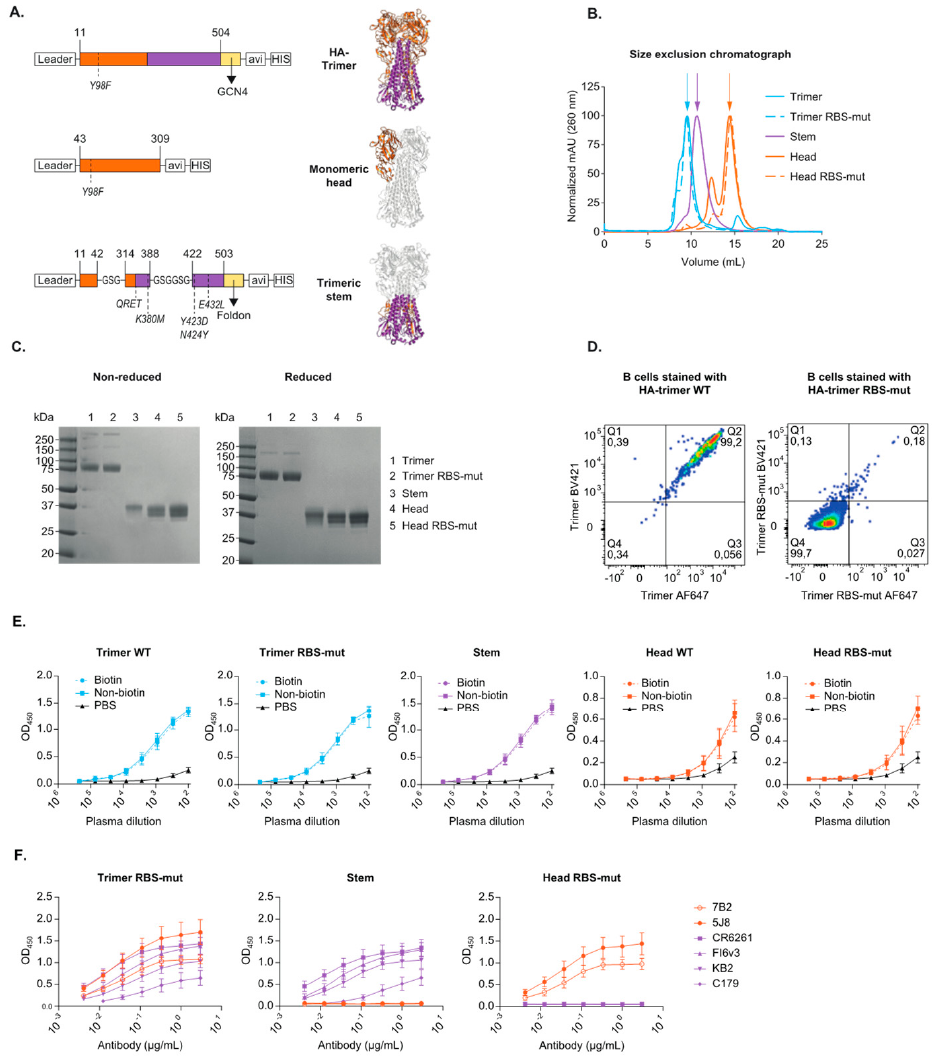
Figure 1. Design and characterization for of H1N1 pdm2009 HA-trimer, trimeric stem and monomeric head probes. ( A ) A linear representation and crystal structure (PDB: 3LZG, adjusted with PyMol) of